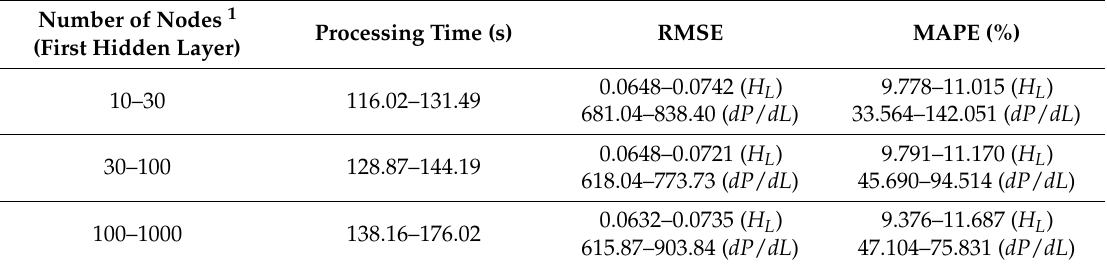
Table 3. Summary of the processing time and the errors for validating the DNN training performances. Number of Nodes